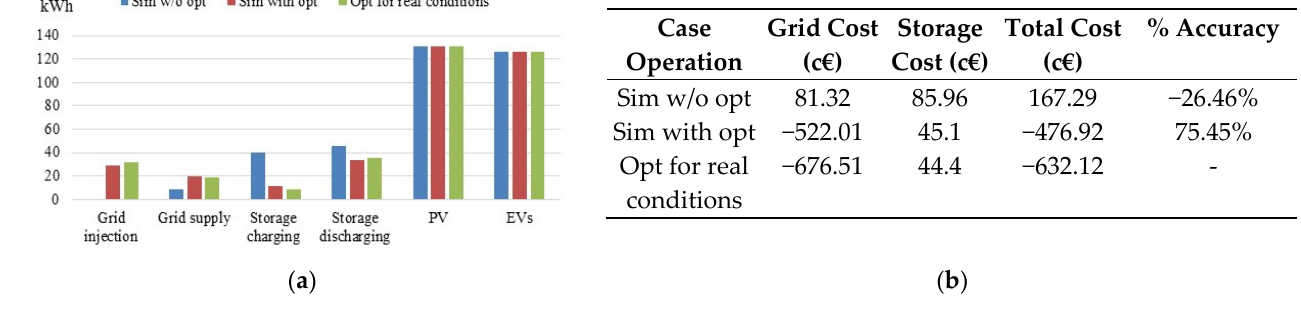
Figure 16. ( a ) Energy system distribution and ( b ) energy system cost—case 3.